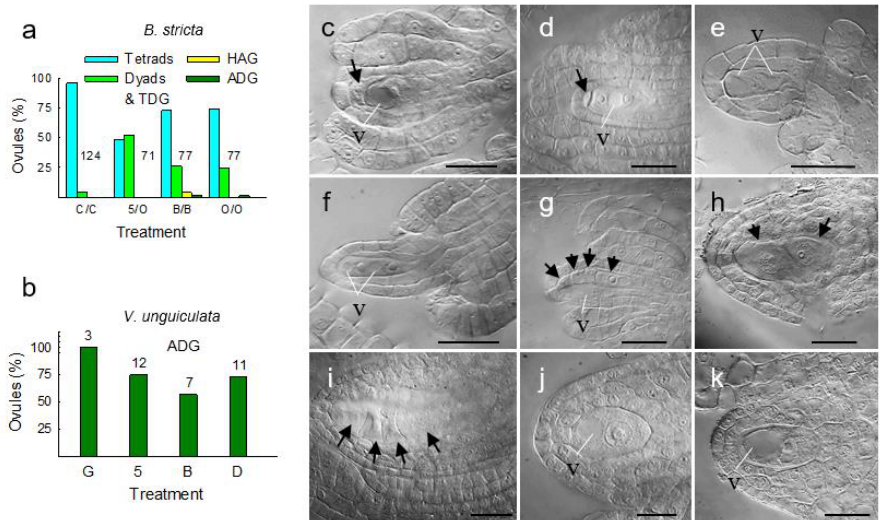
Figure 11. Taraxacum (TDG), Antennaria (ADG) and Hieracium (HAG) types of gametophyte formation induced in sexual Boechera stricta and ADG formation induced in sexual Vigna unguiculata :